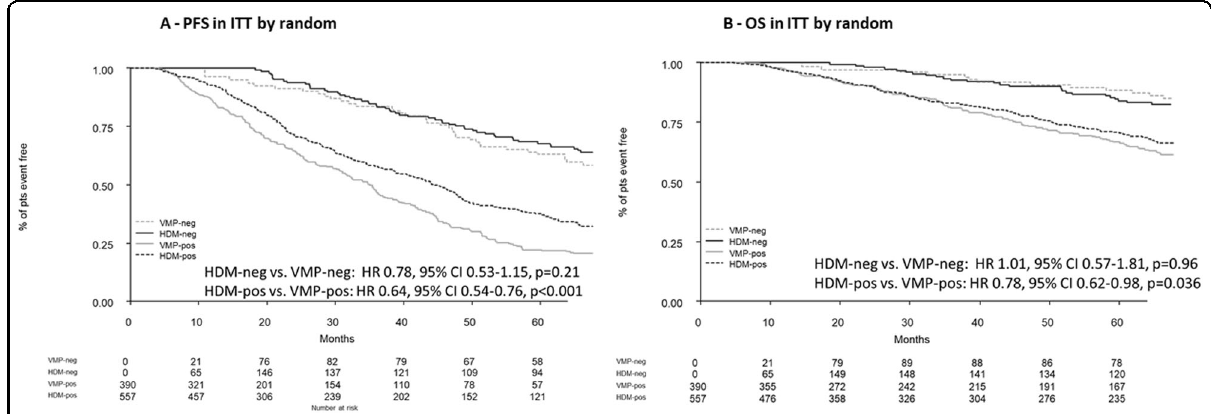
Fig. 5 HDM, high-dose melphalan; VMP, bortezomib-melphalan-prednisone; PFS, progression-free survival; OS, overall survival; ITT, intention-to-treat; pts, patients. A Progression-free survival in the intention-to-treat population by treatment. B Overall survival in the intention-to- treat population by